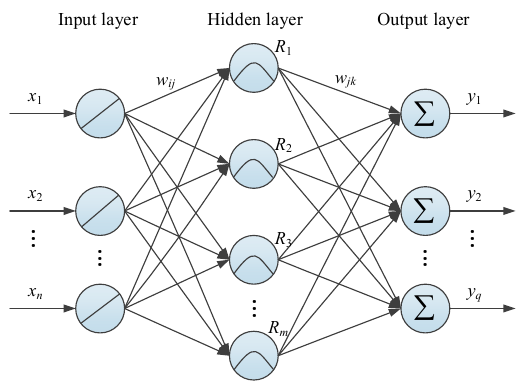
Figure 5. Typical architecture of an radial basis function (RBF) neural network.